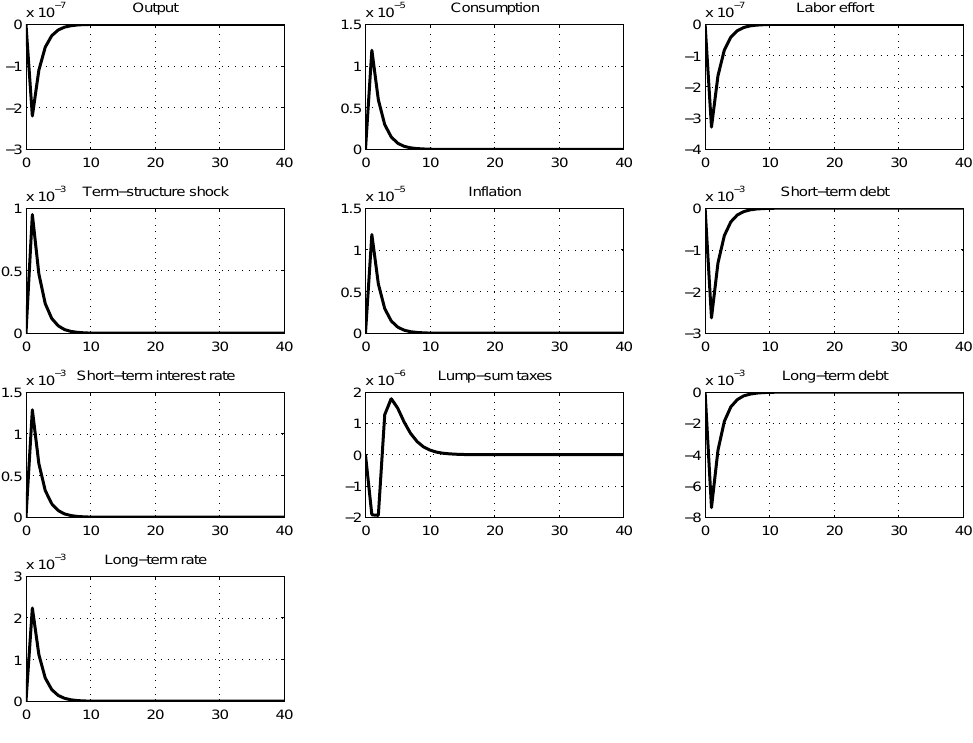
Figure 1. Impulse responses to a term-spread